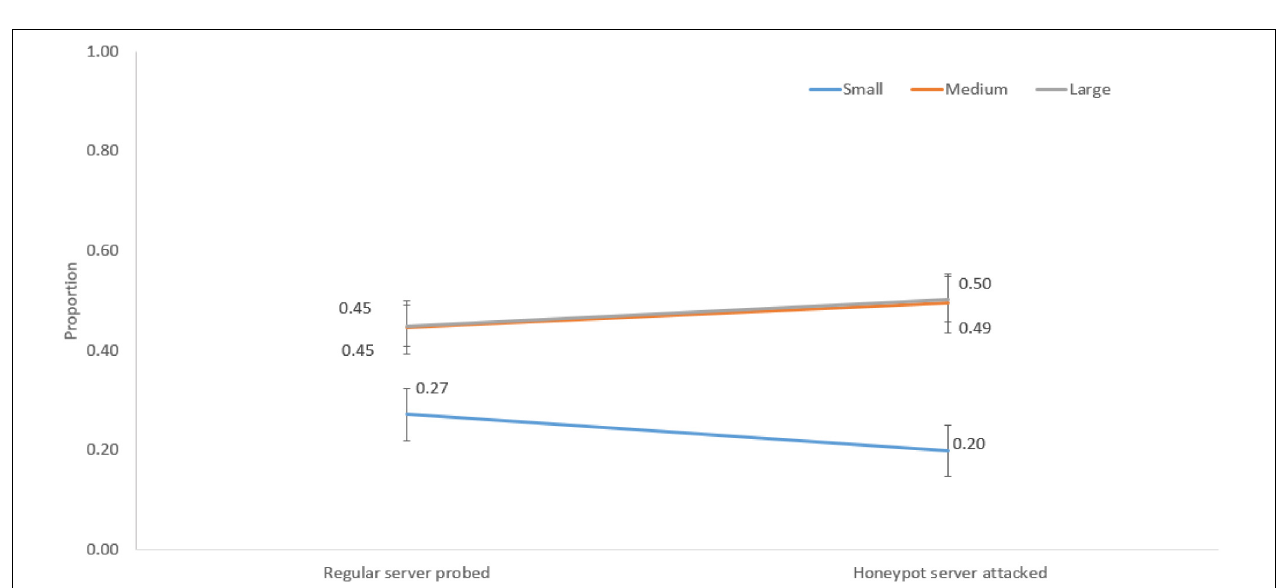
FIGURE 7 | The proportions of honeypot server probed and no server attacked decisions in different network sizes.